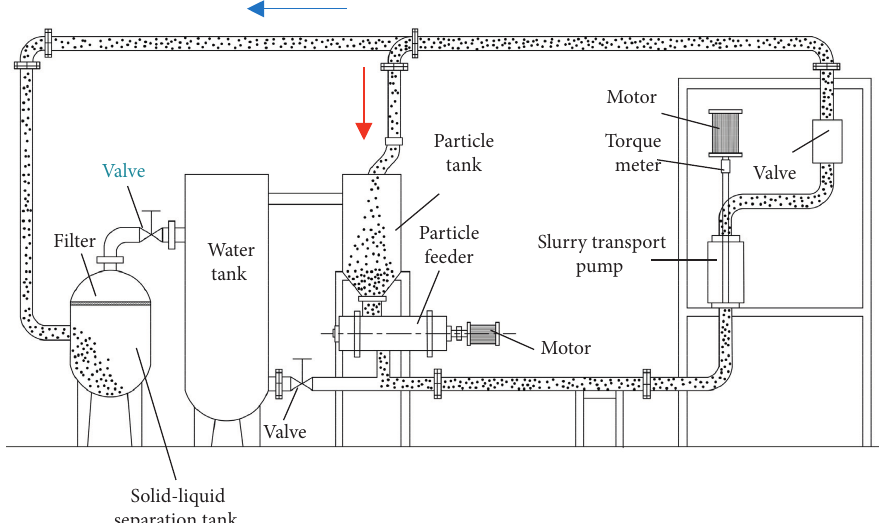
Figure 5: Schematic diagram of experimental apparatus of the slurry transport system.